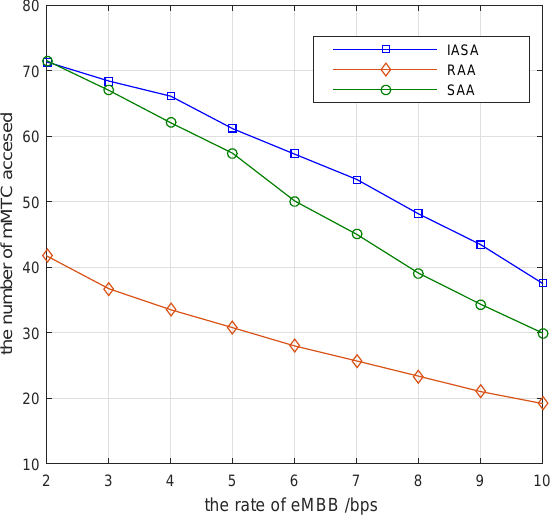
Figure 4. Number of mMTC pairs accessed versus different rate requirements of eMBB